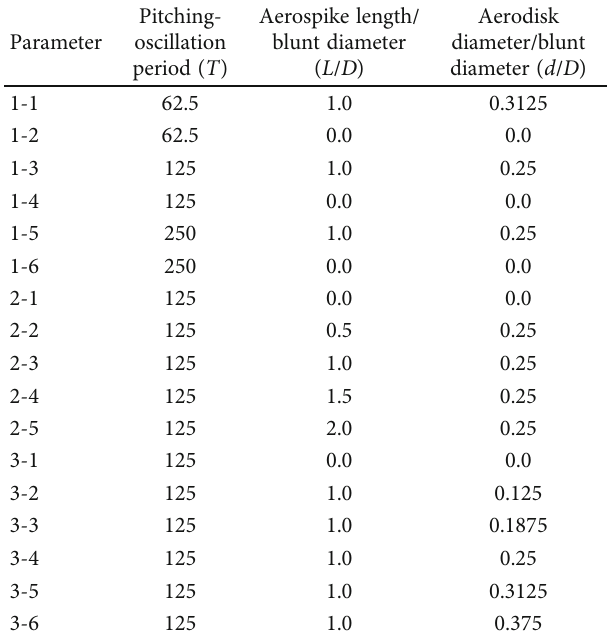
Table 1: Setup of the oscillation period, aerospike length, and aerodisk diameter. D represents the base diameter of the blunt body.